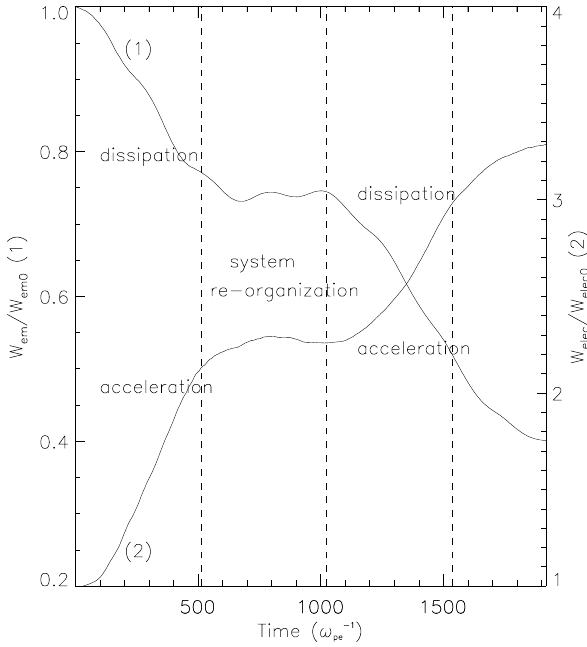
Fig. 11. Wave (label 1) and electron (label 2) energies as functions of time over ∼ 4 Alfv´en